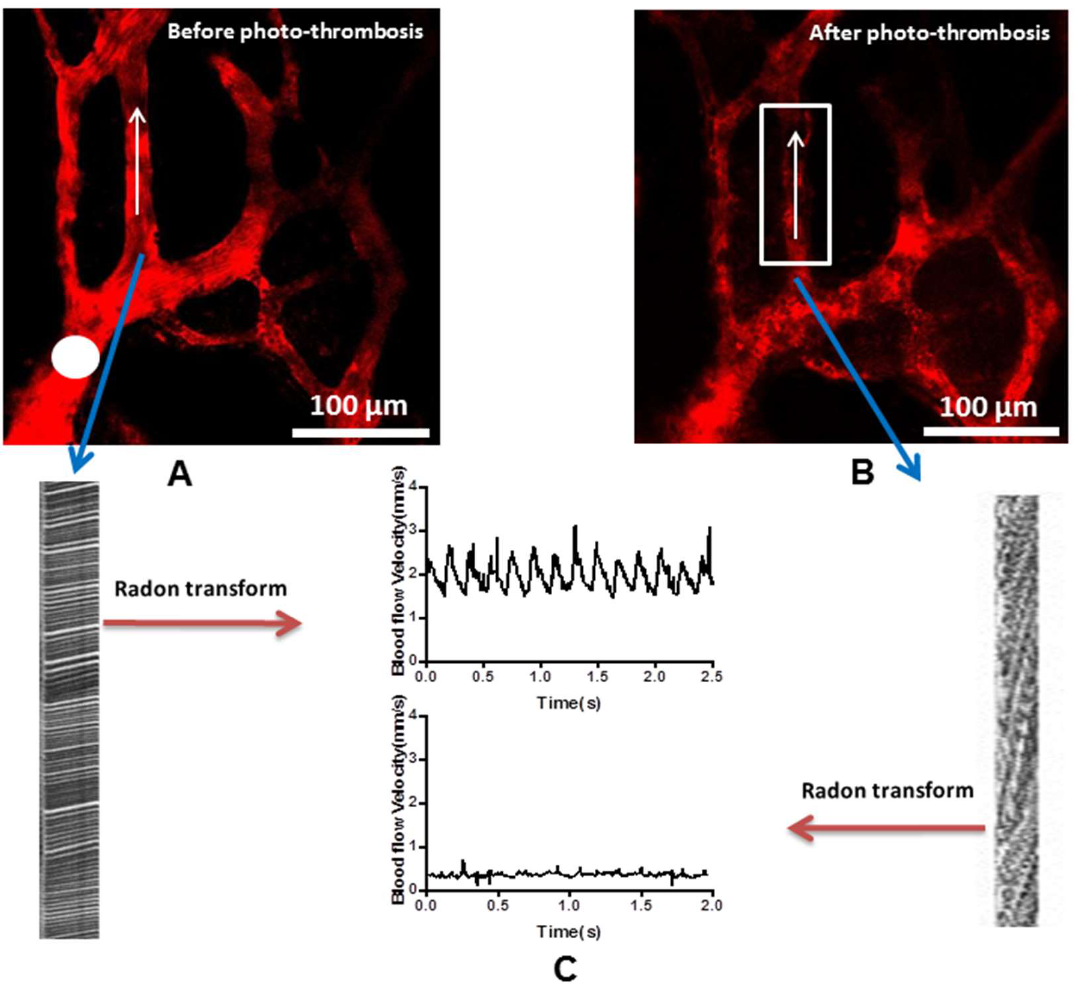
Figure 3. Photo-thrombosis of the arterioles: ( A ) Before photo-thrombosis, white circle demonstrates the target site of the laser beam; ( B ) after photo-thrombosis, many black dots (un-labeled RBC) were noted within the vessel; ( C ) velocity measurement of the blood flow.